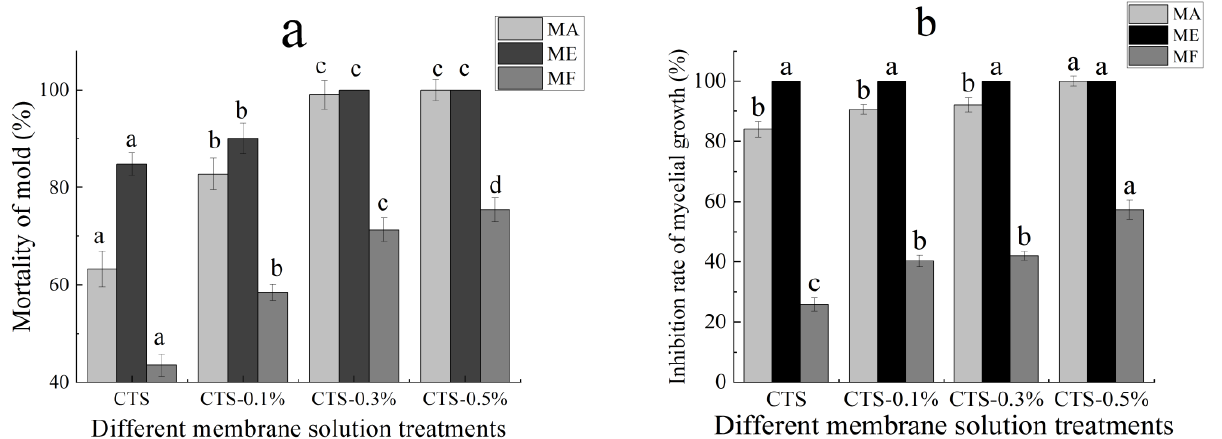
Figure 2. Effect of different concentrations of composite membrane solution on the mortality of mold ( a ) and inhibition rate of mycelial growth ( b ). The bars on the columns indicate standard deviation. Different letters indicate significant differences ( p < 0.05) within an experiment (marked with letters).